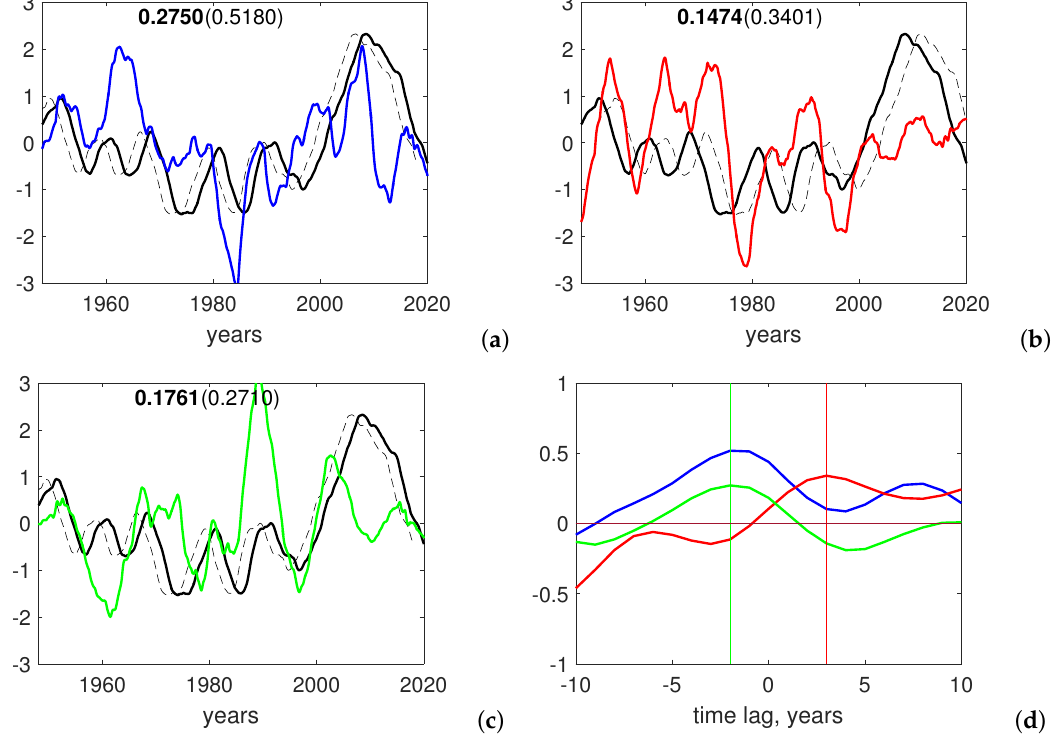
Figure 9. Time change in the rate of total ice growth averaged over the selected areas in comparison with the time variations of the second EOF mode principal component (black): ( a ) the ice growth rate in the FO region (blue), ( b ) the ice growth rate in the region B (red), ( c ) the rate of decrease in ice thickness in the region EL (green) ( d ) the value of the correlation coefficient of these time-series with the principal component depending on the time lag (in years). The geographical position of the areas is shown in Figure 5h. The dashed black line represents the principle component shifted in time by an amount corresponding to the maximum correlation. The first number from the graphs indicates the correlation coefficient of the main series, the second, in brackets, when there is an optimal lag